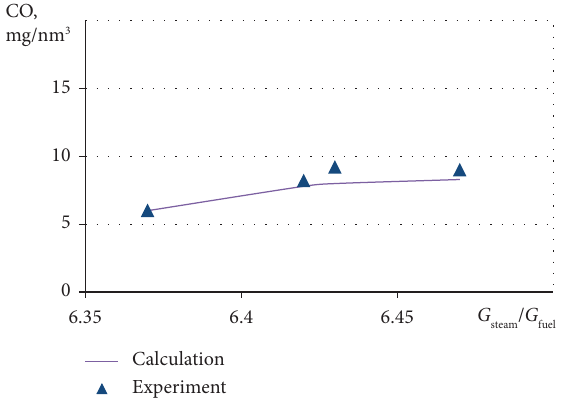
2 concentrations: ▪ -ex- Figure 5: Comparison of experimental and calculated concen- trations of carbon